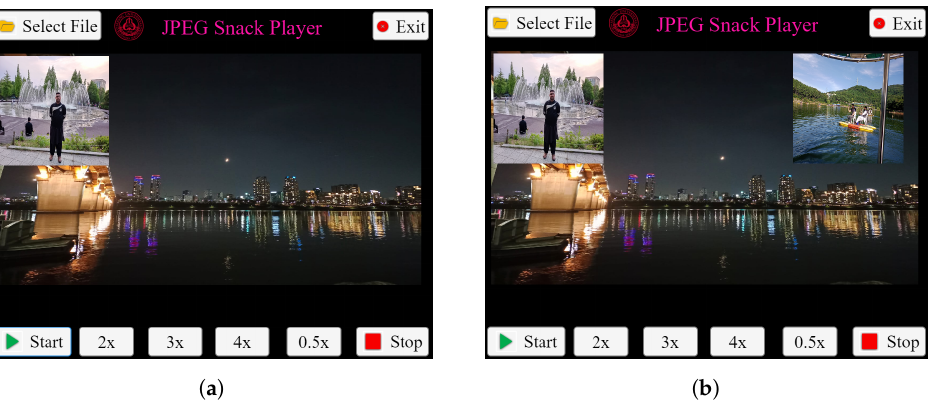
Figure 11. JPEG Snack Player playing a JPEG Snack file with a JPEG image and video embedded in it. ( a ) After 2 s, Object 1 appears. ( b ) After 3 s, Object 2, i.e., video,